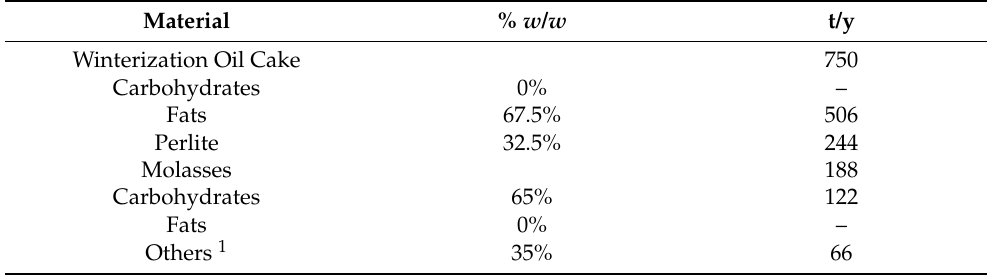
Table 1. Raw material composition and annual flows used in the base model. Material % w / w t/y Winterization Oil